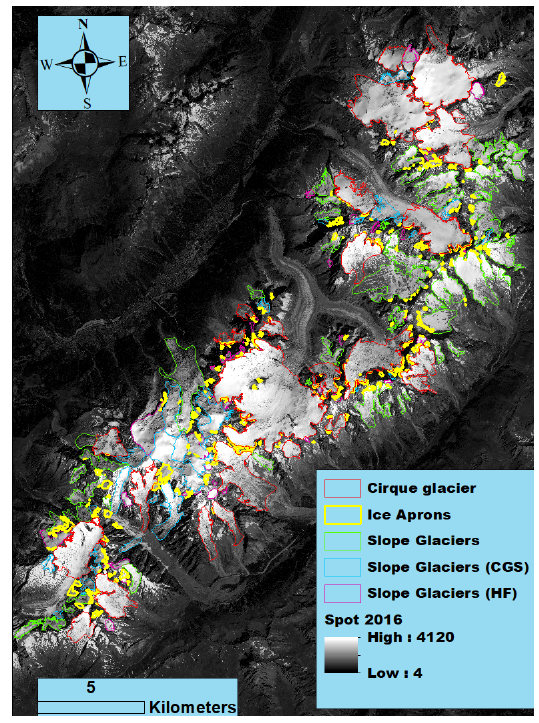
Figure 3. Glacier types in the